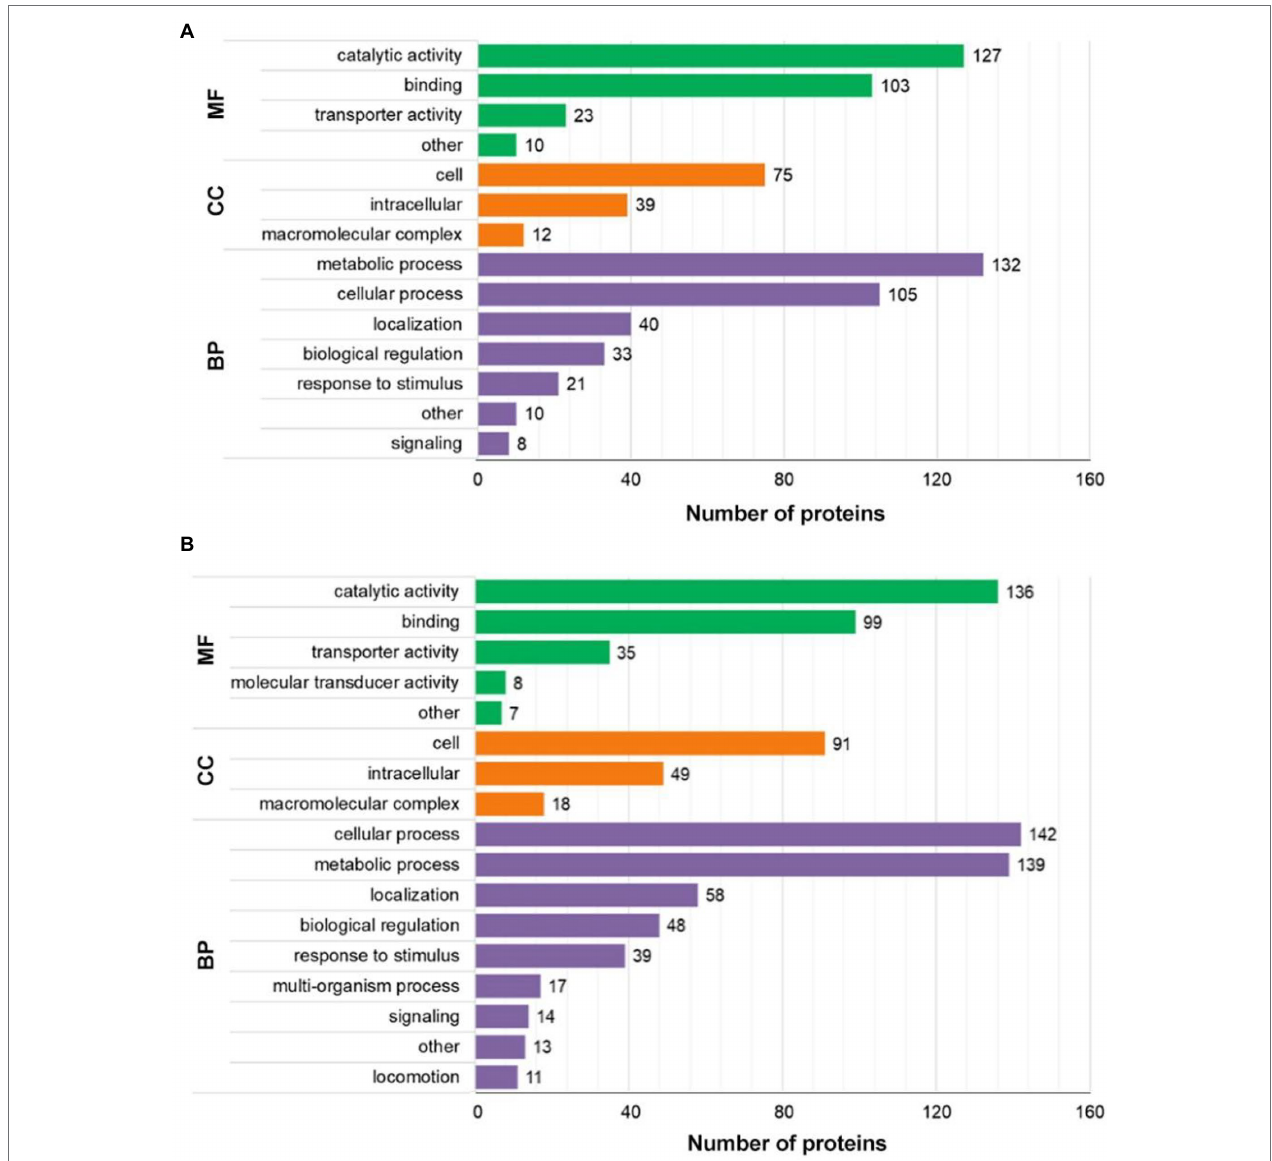
FIGURE 3 | GO analysis of differentially expressed proteins. (A) The number of upregulated proteins categorized as molecular function, cellular component, and biological process. (B) The number of downregulated proteins categorized as molecular function, cellular component, and biological process. BP, biological process; CC, cellular compartment; and MF, molecular function.